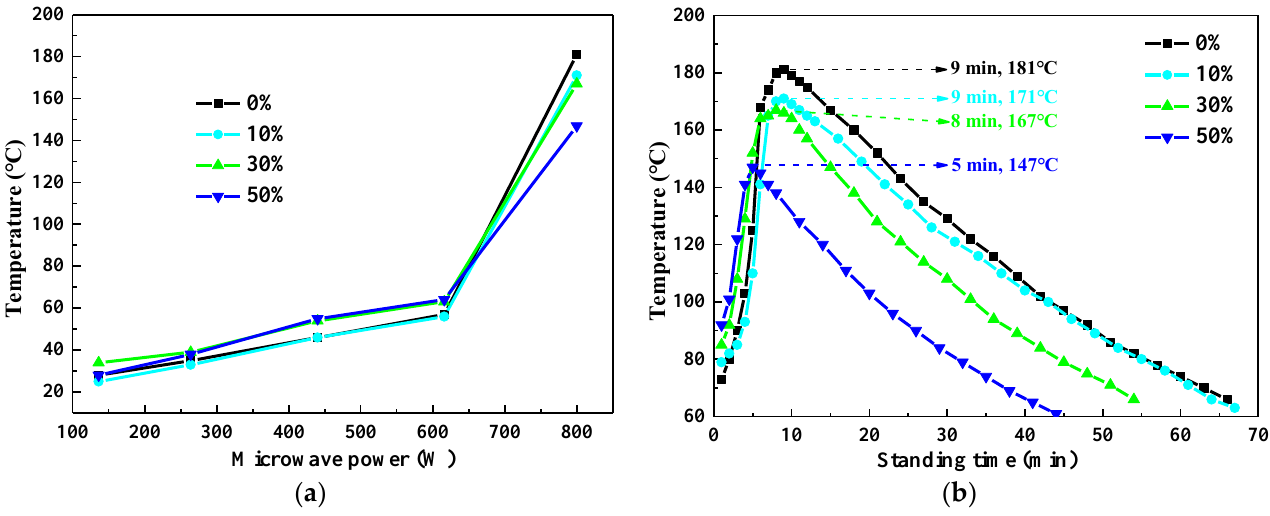
Figure 7. ( a ) Temperature of the UPR composites containing CaCO 3 under different microwave powers for 30 s. ( b ) Temperature curves of the UPR composites after microwave irradiation under 800 W for 30 s.